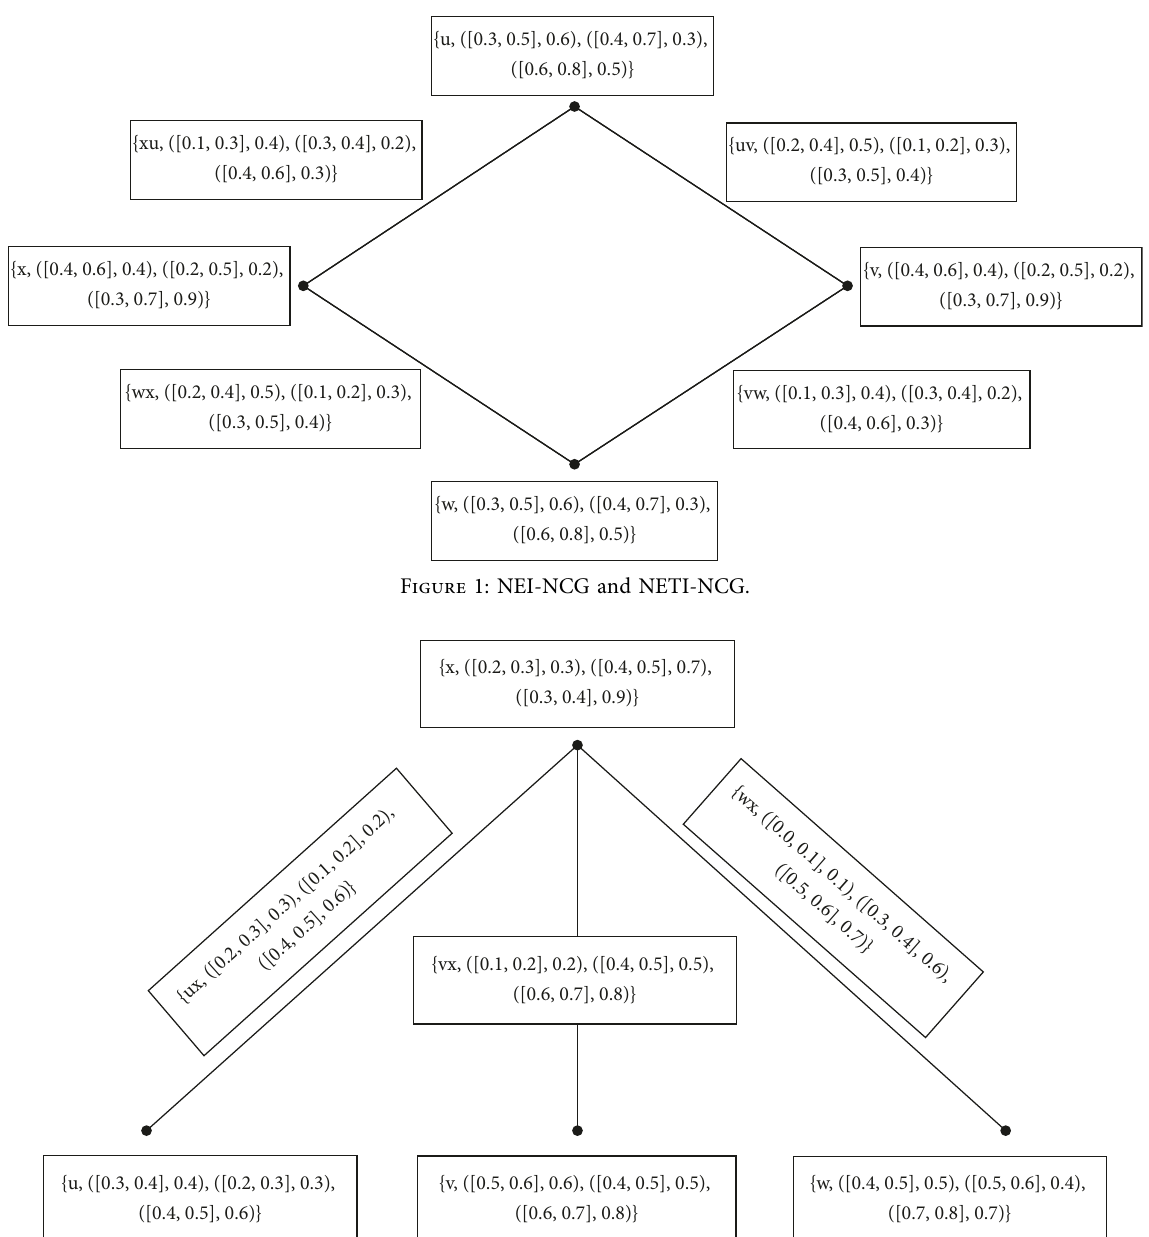
Figure 2: G is NEI-NCG but it is not